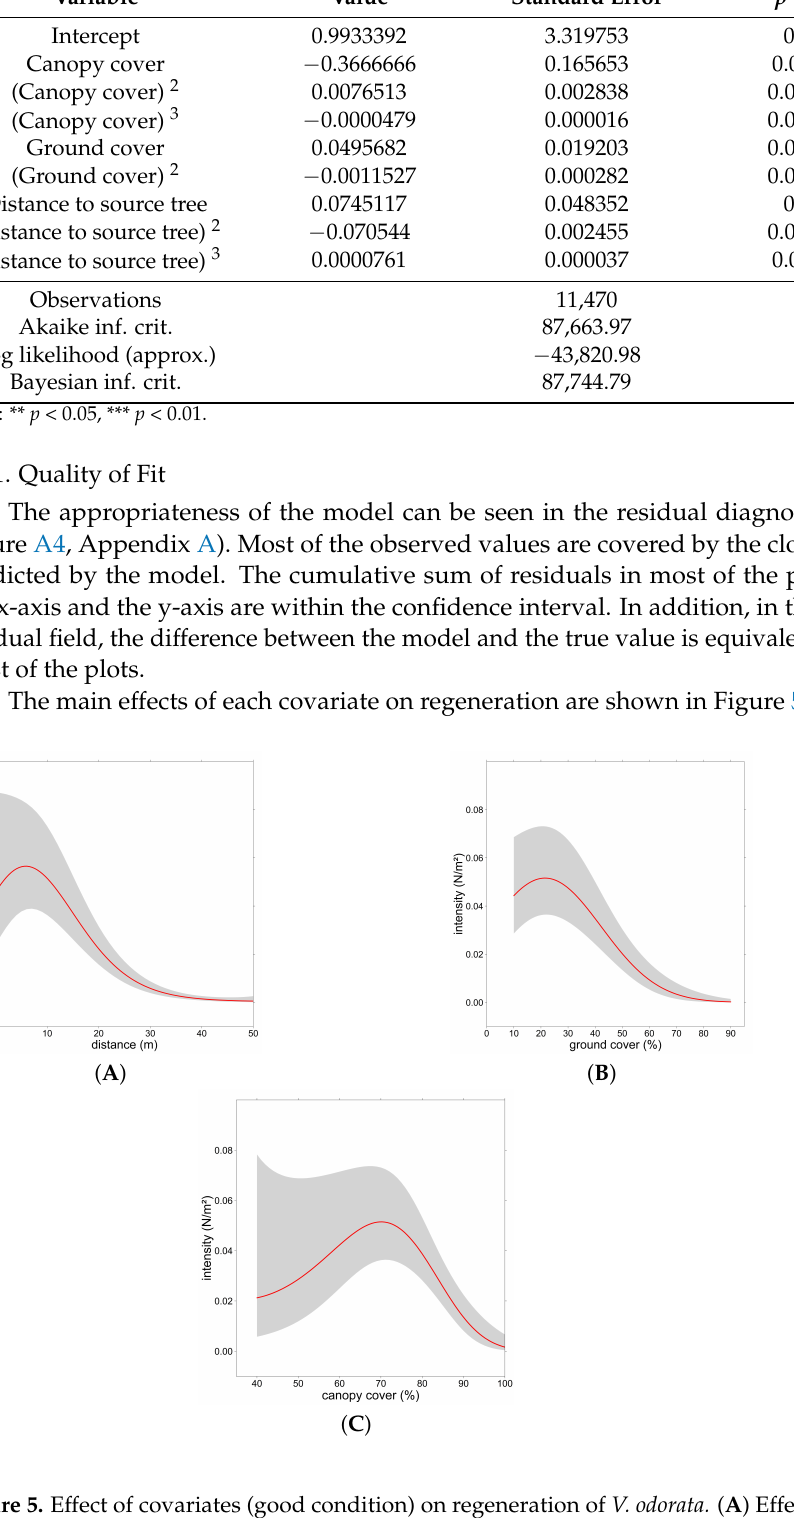
Table 3. Summary of model results, parameters. Note that the superscripts represent the 2nd and 3rd power. See also Equation (4) in the Section 2.